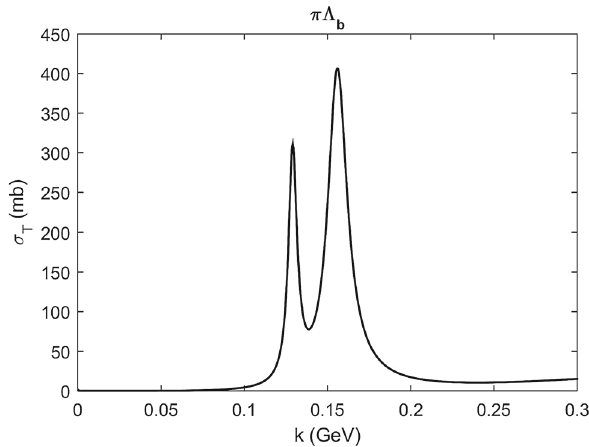
Fig. 3 Total cross section of the π(cid:2) b interaction